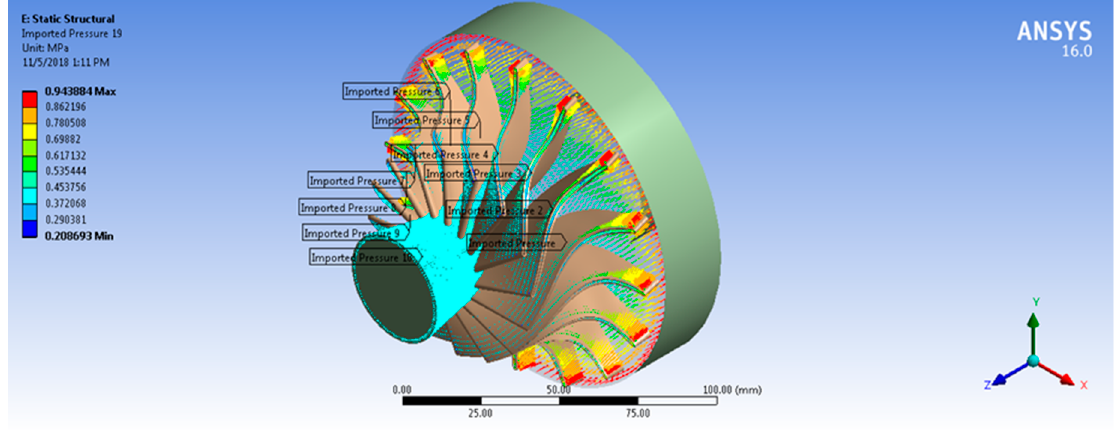
( d ) Figure 10. An ACP composite model for the rotor blade with different fiber orientations:( a ) 30° from the blade edge, ( b ) 40° from the blade edge, ( c ) 50° from the blade edge, and ( d ) 60° from the blade edge. 2.2.3. Fluid–Structure Interaction Model Setup Fluid–structure interaction can be considered as the result of the mutual interaction of three main disciplines: dynamics, solid mechanics, and aerodynamics [18]. The one-way FSI system was used in this analysis. For the static structural analysis, the boundary conditions and loads are defined for the model in order to determine the stresses and deflections in the turbine. These loads are caused by the temperature and pressure of the working fluid, and turbine rotational speed. Based on Ansys- CFX simulation results, the aerodynamic pressure force on the rotor blades and thermal loads due to working fluid temperature are transferred to a static structural model and solved for equivalent von Mises stress and total deformation. Therefore, ANSYS is mapping the forces on each node from CFX into the mechanical node. Consequently, the position of the blade geometry in CFX module and Static Structural module must be same with reference to the global coordinate system. The results showed that 97% of mechanical nodes were mapped to the CFD surface. Both Figures 11 and 12 show the